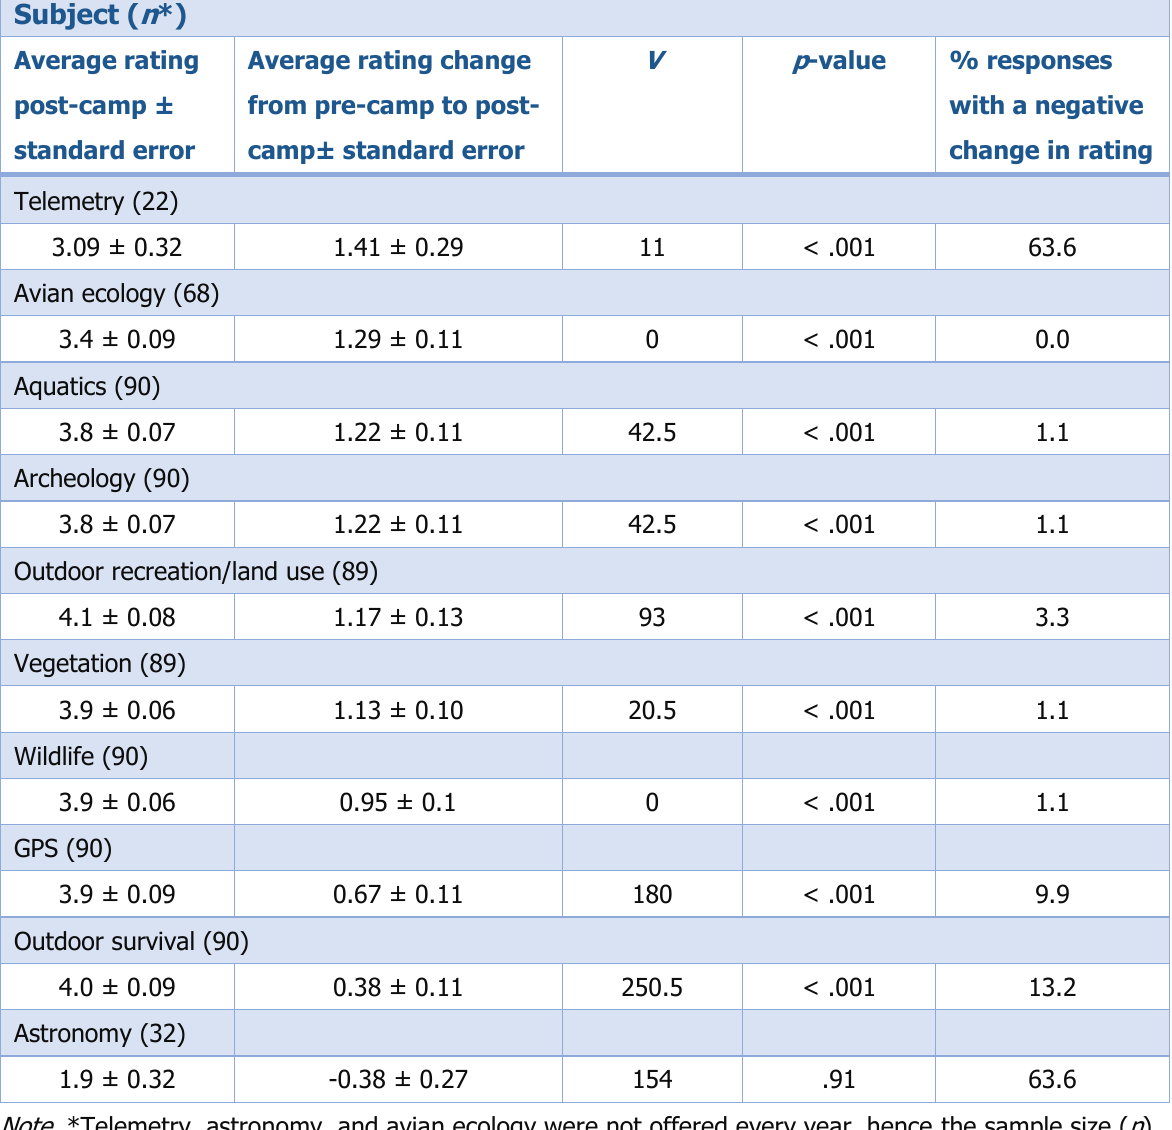
Table 2: Comparison of Participants’ Natural Resources Knowledge Survey Responses Before and After CCNRC Attendance, 2013 -